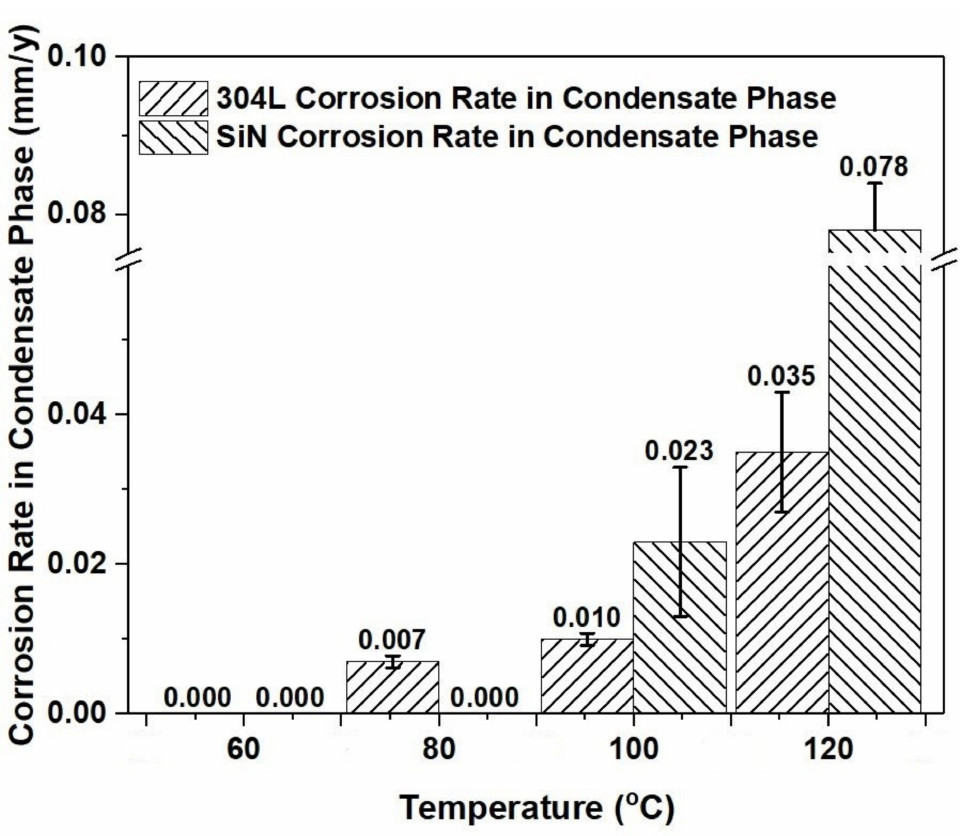
Figure 12. Corrosion rates of SiN and 304L stainless steels in nitric acid condensate phase at different temperatures.